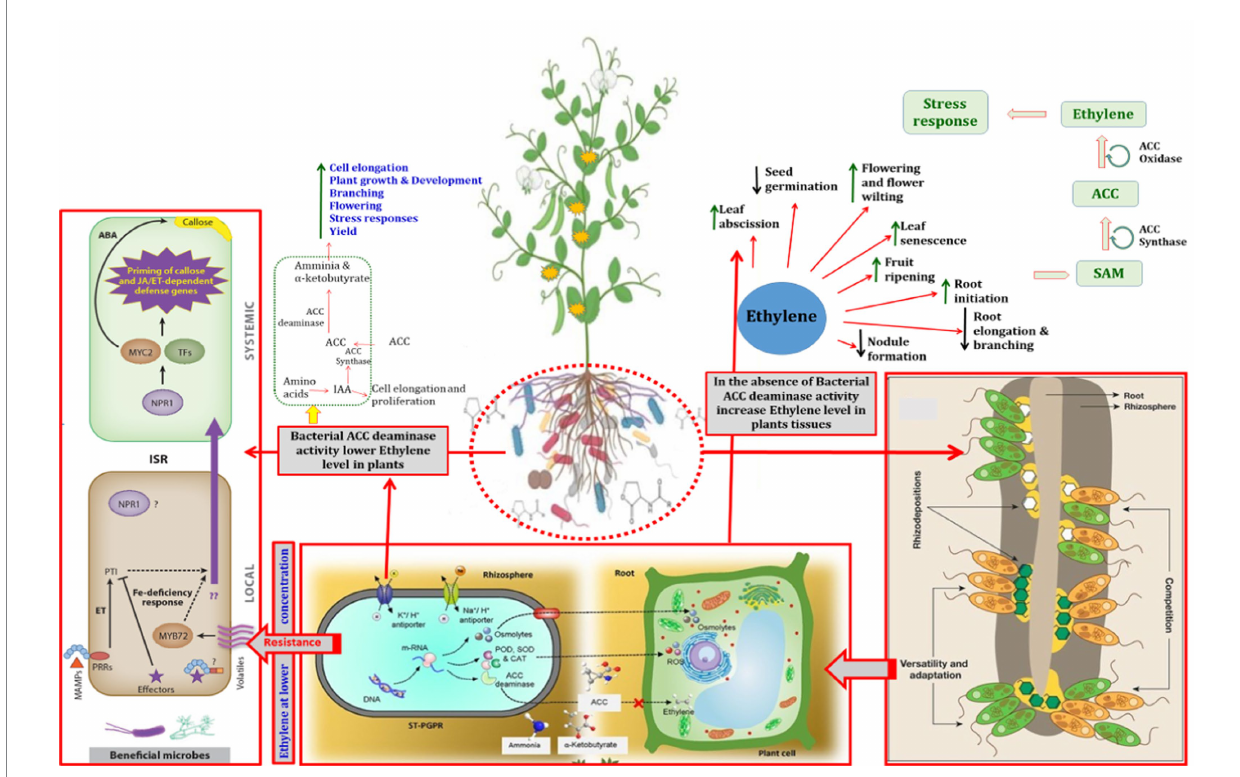
FIGURE 4 Representation of the direct and indirect roles of bacterial ACC deaminase in plant growth and development. MAMPs represent microbe-associated molecular patterns; ET, ethylene; PTI, PAMP triggered immunity; ISR, induced systemic resistance; TFs, transcription factors; ABA, abscisic acid; POD, peroxidase; SOD, superoxide dismutase; CAT, catalase; PGPRs, plant growth promoting rhizobacteria; ROS, reactive oxygen species; JA: jasmonic